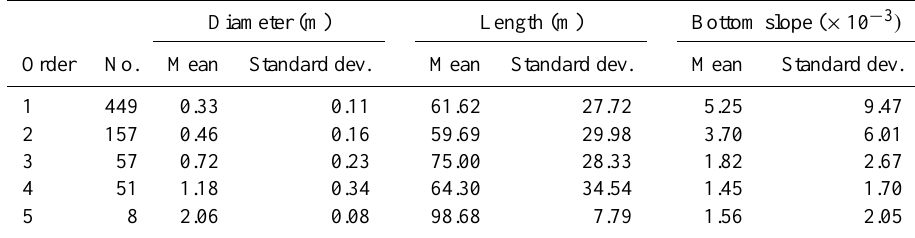
Table 2. Conduits of CDS-51 according to the Strahler ordering (Miller et al., 2009). Diameter (m) Length (m) Bottom slope ( × 10 − 3 ) Order No. Mean Standard dev. Mean Standard dev. Mean Standard dev. 449 0.33